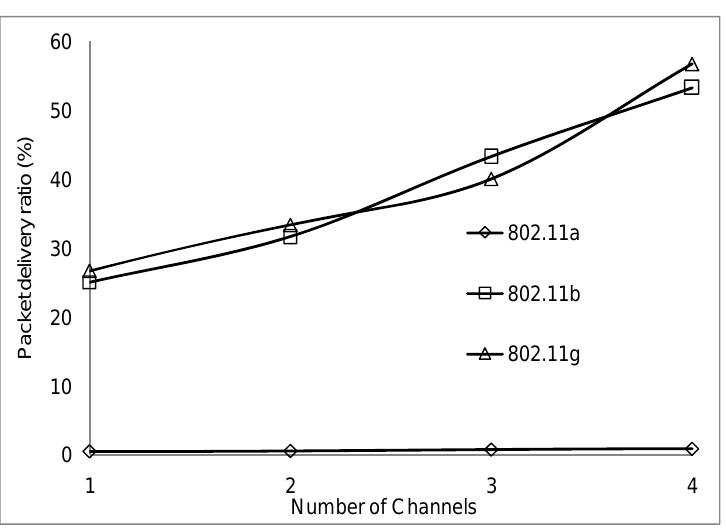
Figure 30. Delivery ratio at 50 m range and data rate of 2